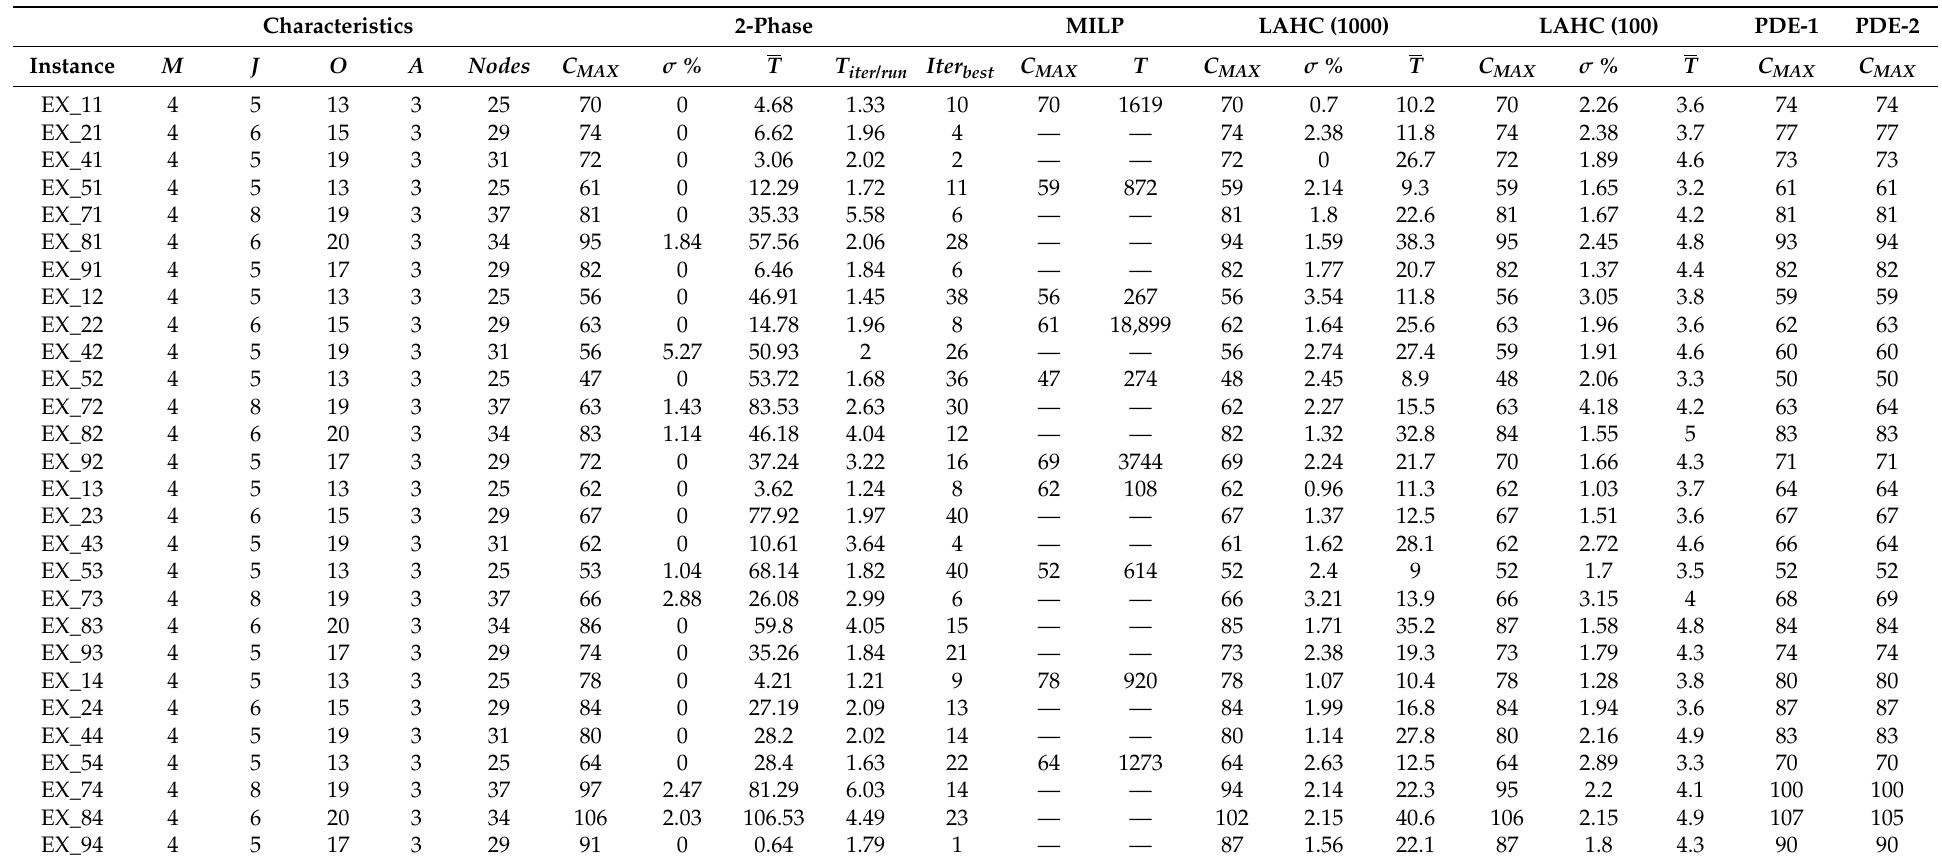
Table 5. Performance comparison of two-phase heuristic with existing approaches on Kumar, Janardhana and Rao [11] test instances with ratio greater than 0.25.